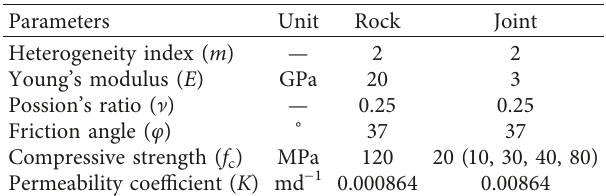
Figure 7: Schematic of the model set. (a) Parallel joint model. (b) Multijoint model. (c). Masonry-shaped joint model. Table 1: Physicomechanical parameters of rock and joint employed in